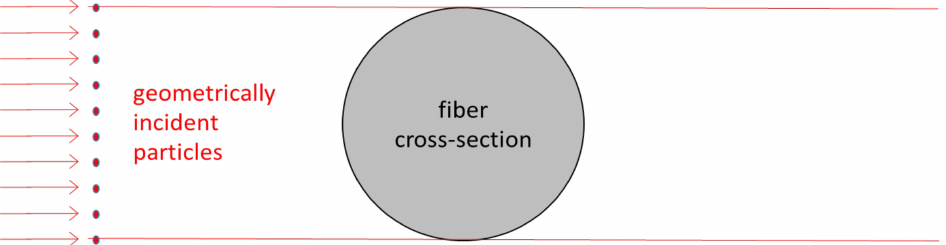
Figure A1. Geometrically incident particles approaching a fiber cross